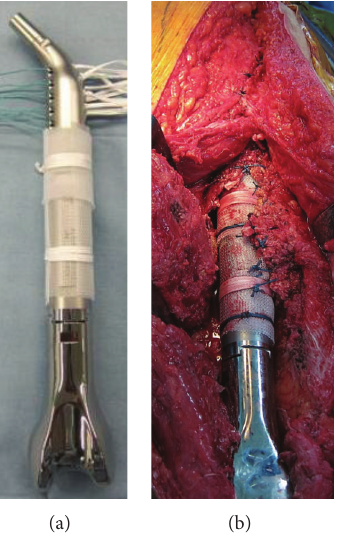
Figure 3: A photograph of the implanted total femur prosthesis (a). Polypropylene meshes wrapped around the prosthesis to create attachment of the surrounding soft tissue